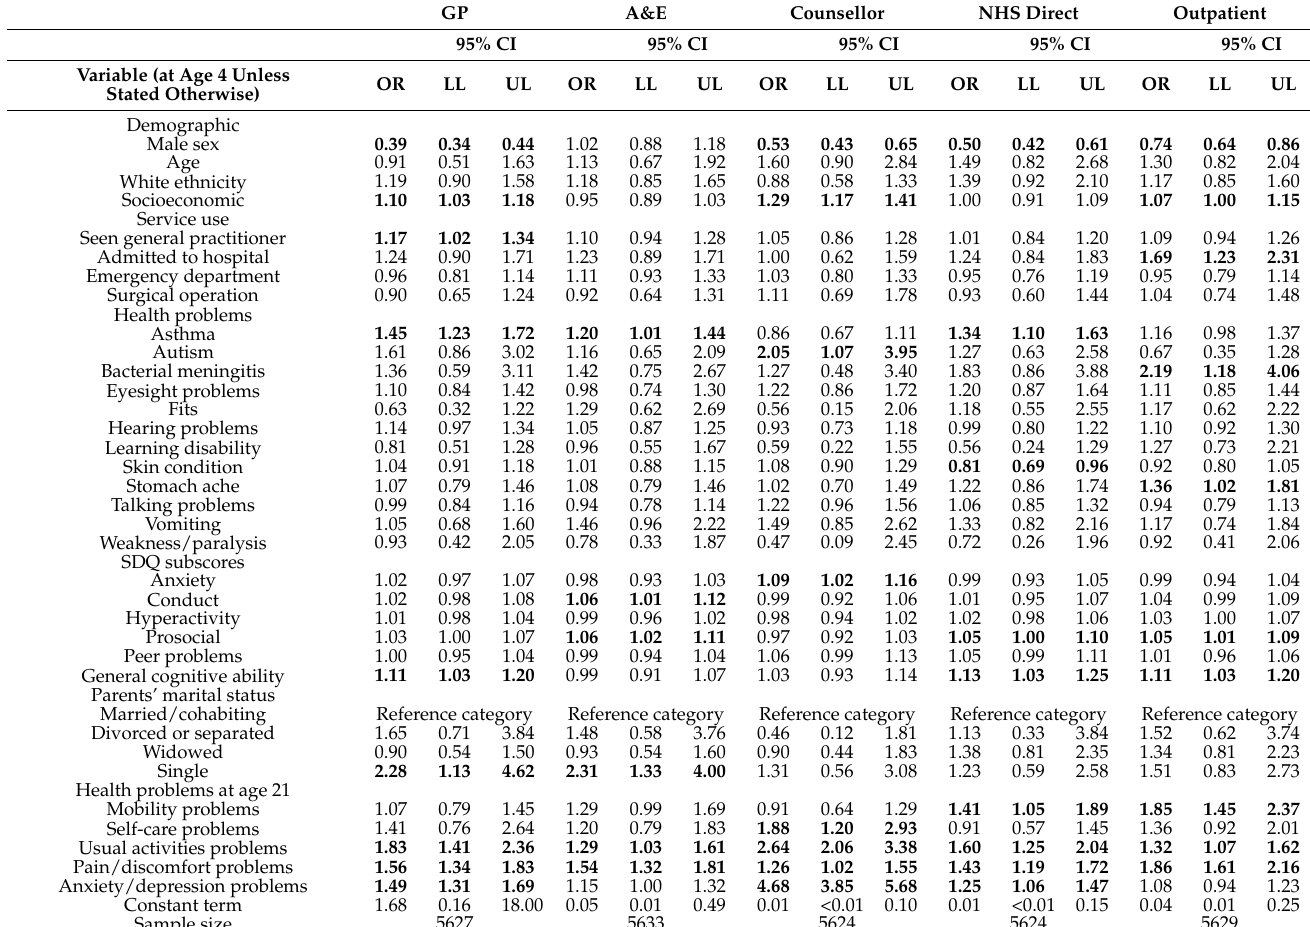
Table 4. Generalised estimating equations showing predictors of service use at age